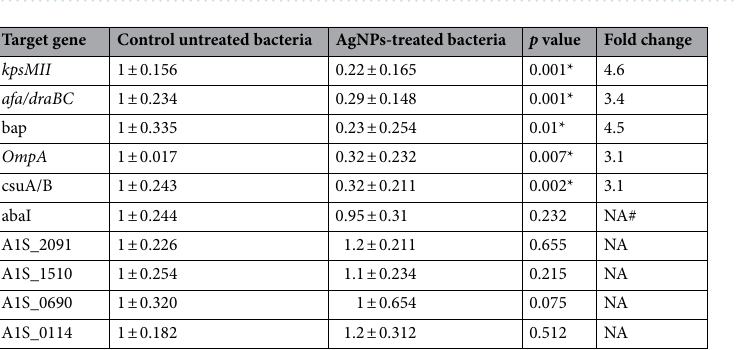
Figure 2. Antibacterial activity of AgNPs on the isolated A . baumannii . ( A ) Inhibition zone diameters induced by the silver nanoparticles. ( B ) Growth kinetics of 3 representative A. baumannii from each group in the presence of AgNPs. The microbial growth was estimated by the optical density (OD595). ( C ) MIC values according to strength of biofilm formation. ( D ) Effect of silver nanoparticles on biofilm inhibition and biofilm dispersion. Untreated bacteria were used as control. Columns show the mean ± SD. * p < 0.05 indicates statistical significance as compared to control by Student’s t-test.